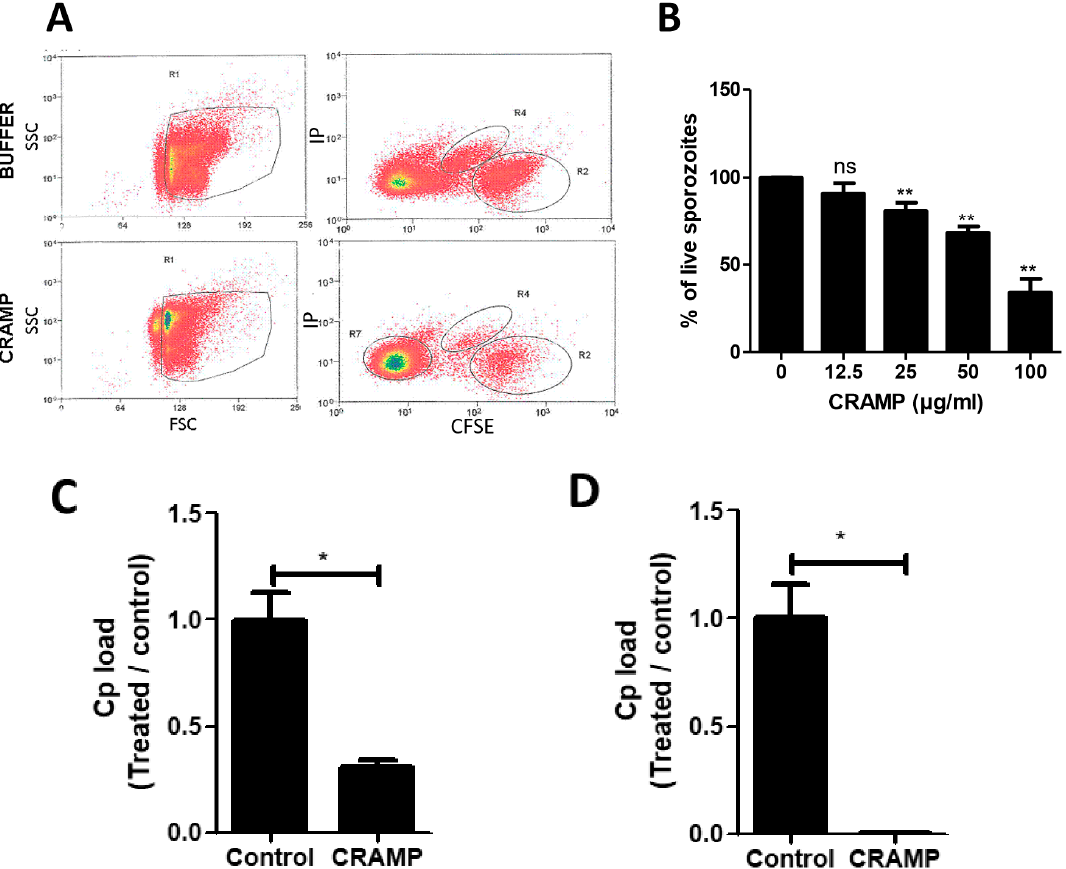
Figure 5. CRAMP displays antimicrobial activity against C. parvum sporozoites. ( A ) C. parvum sporozoites were purified and incubated with 50 µg/mL ( A ) or with different doses ( B ) of CRAMP for 3 h at 37 °C in phosphate buffer containing 50mM NaCl. Sporozoites were incubated with CFDA-SE (8 µg/mL) and propidium iodide (5 µg/mL) to assess their viability by flow cytometry ( A , B ). Oocysts ( C ) and sporozoites ( D ) of C. parvum were incubated for 3 h with 100 µg/mL of CRAMP before their addition to mICcl2 cells (MOI 10). The infection rate was analyzed by quantifying C. parvum 18S RNA 24 h later by qRT-PCR. Statistical analyses* p < 0.05, ** p < 0.001.